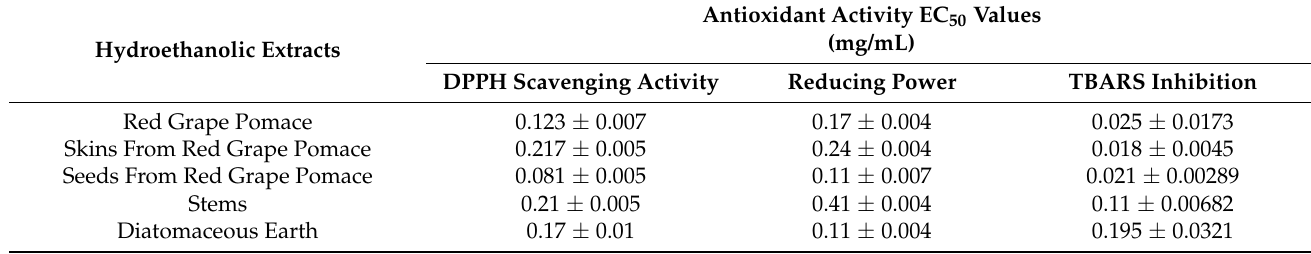
Table 3. Antioxidant activity of extracts obtained from winemaking